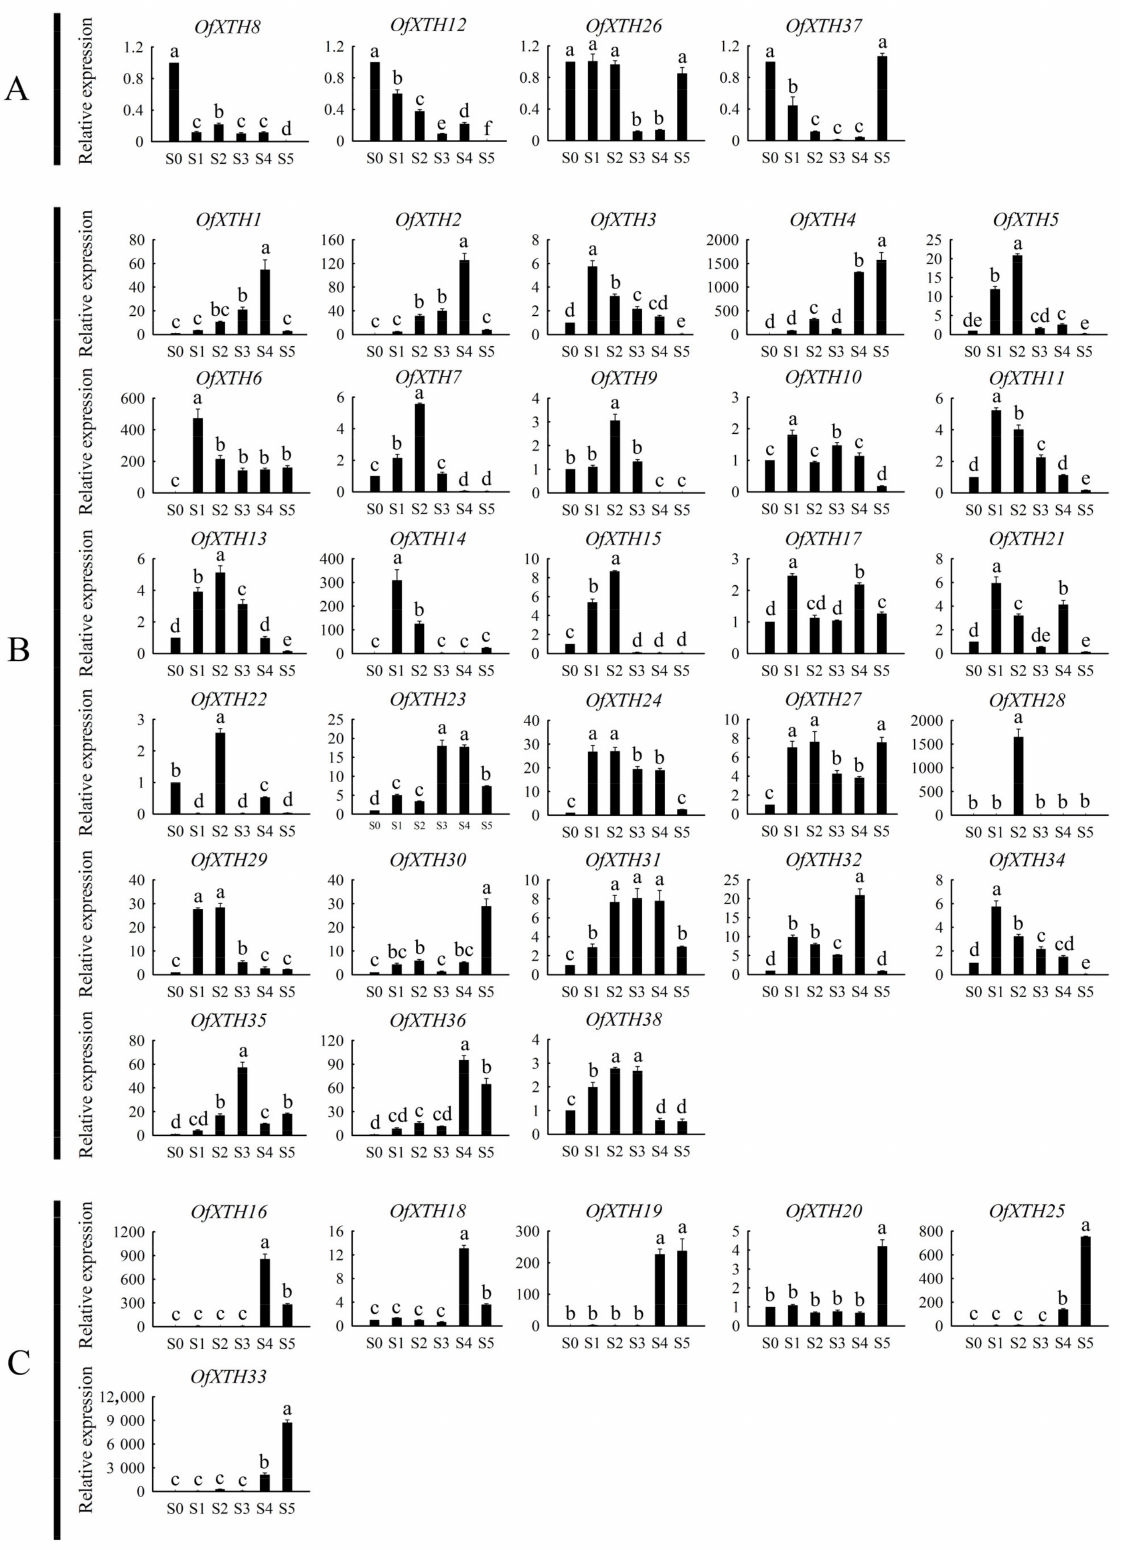
Figure 6. Expression profiles of OfXTHs at different flowering stages. Significant differences are iden- tified by SPSS (version 22) with Duncan’s test ( p < 0.05) and are represented by different letters above the error bars. ( A ) OfXTH genes highly expressed in the S0 period. ( B ) OfXTH genes upregulated in the S1 and S2 period. ( C ) OfXTH genes upregulated in the S4 and S5